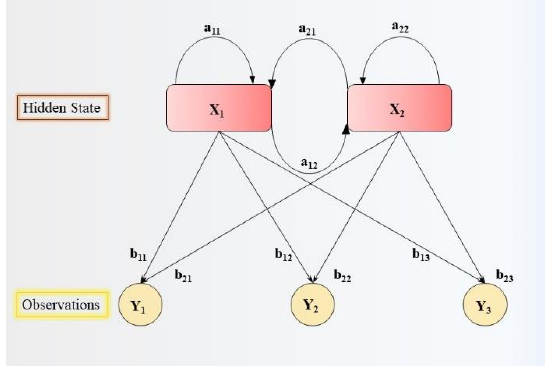
Figure 14. The structure of hidden Markov model.